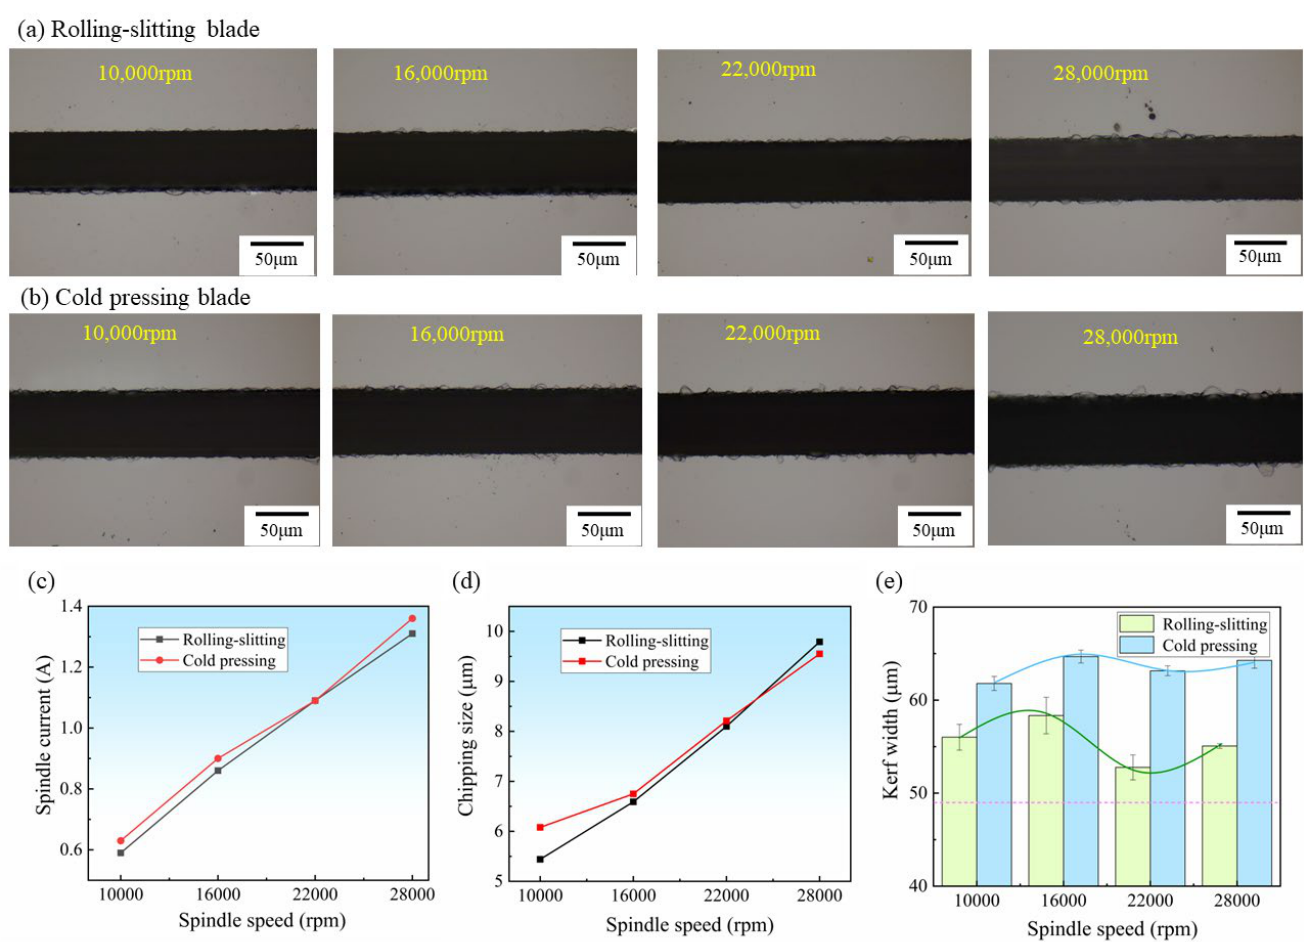
Figure 7. Result of SiC wafer diced at different spindle speeds, feed rate vf = 1 mm/s dicing depth ap = 0.2 mm: ( a , b ) Surface morphology of SiC, ( c ) Spindle current, ( d ) Maximum chipping size, ( e ) Kerf width.